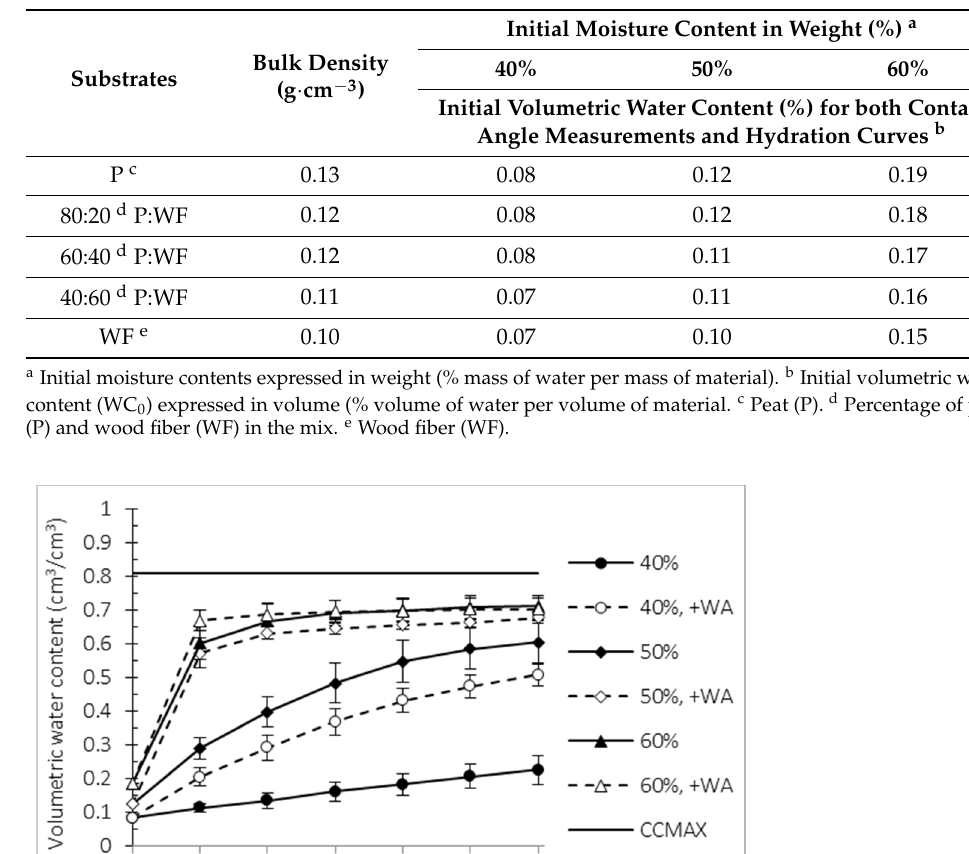
Table 1. Initial moisture contents expressed in weight and volumetric water contents for peat, wood fiber and mixes peat:wood fiber.